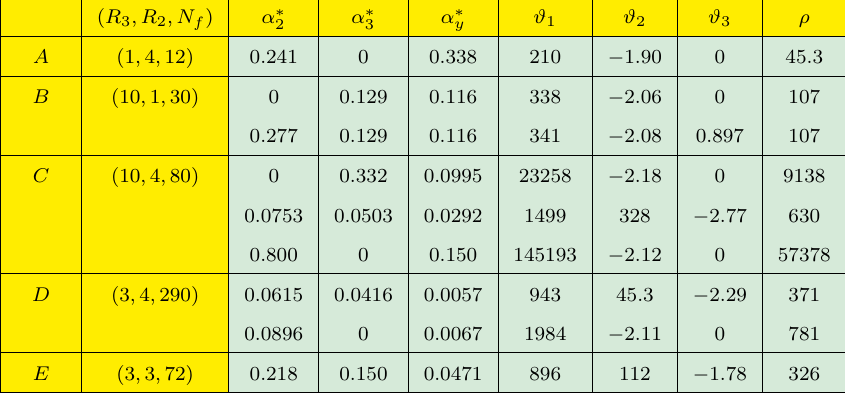
Table 9 . Couplings, eigenvalues and the ratios (cid:26) i , with i = 2 ; 3 depending on the case, for the benchmark models in [15] for the 210 approximation scheme.